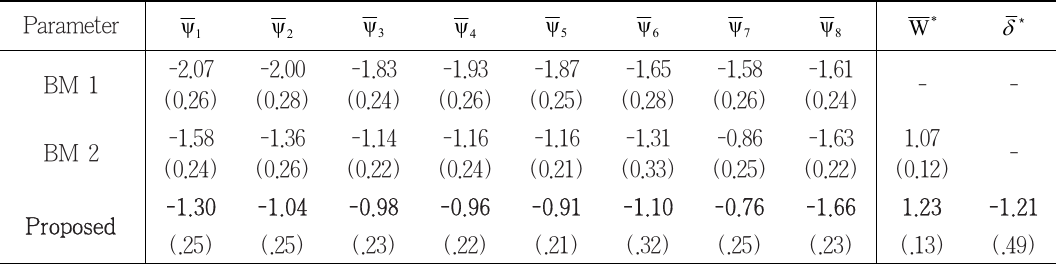
<Table 4> Posterior distribution of parameters: